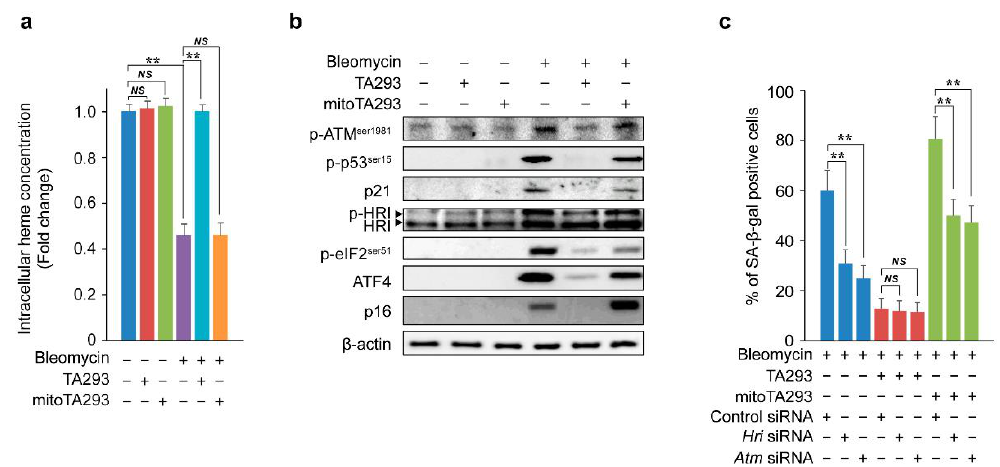
Figure 5. Effects of TA293 and mitoTA293 on p-ATM ser1981 /p-p53 ser15 /p21 and p-HRI/p-eIF2/ATF4/p16 pathways in BLM- induced PAECs in vitro . ( a ) Intracellular heme concentration. ( b ) Expression of p21, ATF4, and p16 and phosphorylation of ATM ser1981 , p53 ser15 , HRI, and eIF2 ser51 visualized by western blotting. PAECs were treated with saline or BLM and with vehicle, TA293, or mitoTA293 for 72 h. ( c ) Effect of Hri and Atm siRNA on cellular senescence. The data are presented as the mean ± SEM ( n = 5 per group); ** p < 0.01; NS , not significant.